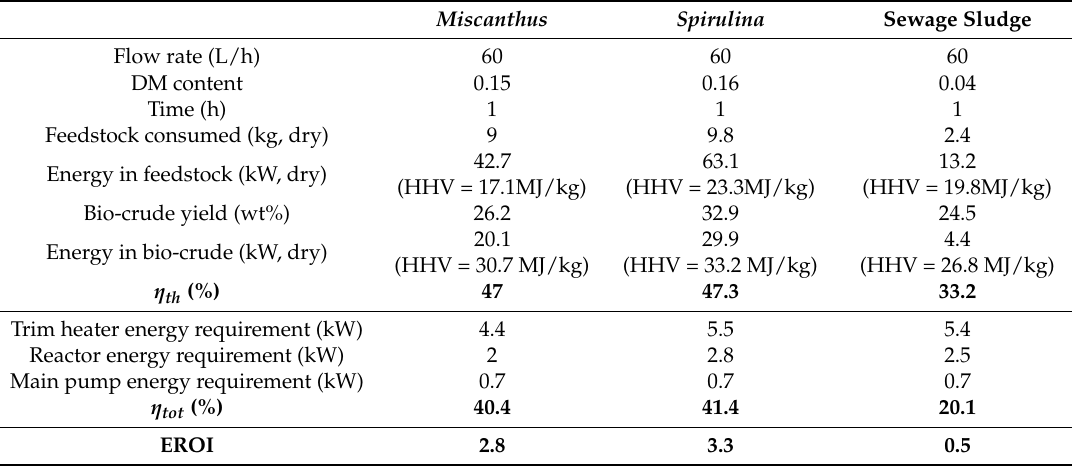
Table 6. Process efficiency during HTL of Miscanthus , Spirulina and sewage